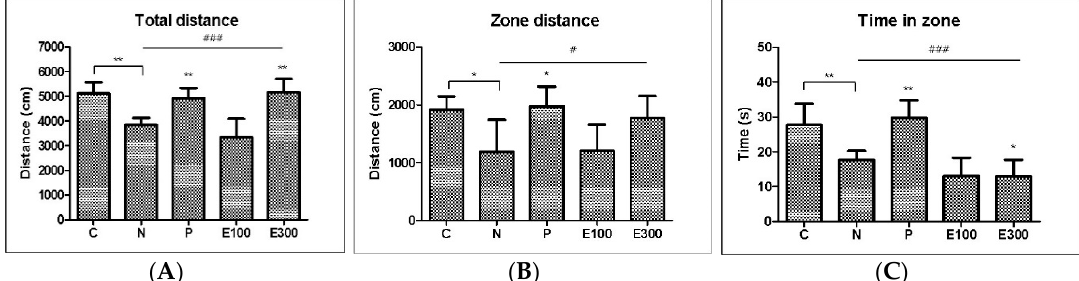
Figure 3. Behavioral analysis of the open field test (OFT) after intraperitoneal injection of fluoxetine and oral administration of the extract into mice ( n = 7). ( A ) Total distance; ( B ) Zone distance; ( C ) Time in zone. C: normal control; N: negative control (CUMS); P: positive control (CUMS + 15 mg/kg fluoxetine); E100 and E300: doses of the extract (CUMS + 100 and 300 mg/kg, respectively). #: Kruskal- Wallis test; *: Mann-Whitney test. #: p < 0.05; ###: p < 0.001; *: p < 0.05; **: p < 0.01.